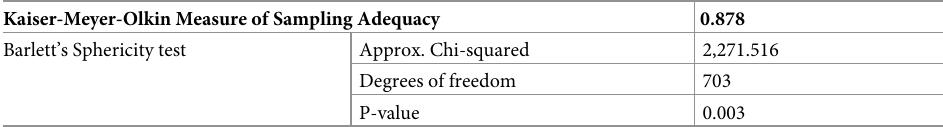
Table 6. Appropriateness for applying the main component analysis.